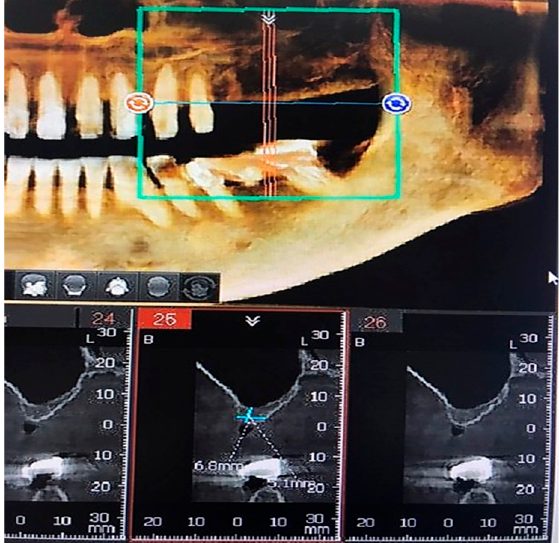
Figure 7. Cone-beam computed tomography (CT) images before treatment.